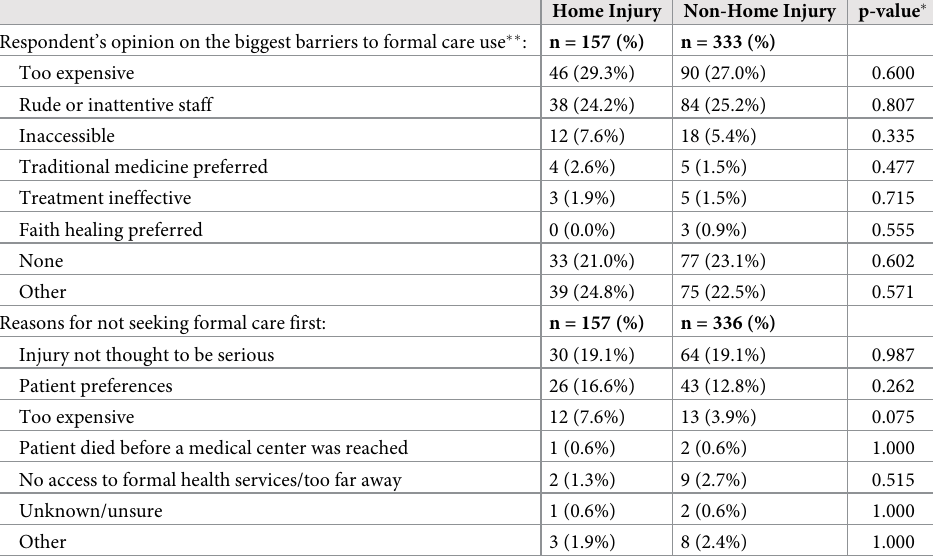
Table 4. Barriers to formal care utilization amongst home injured in